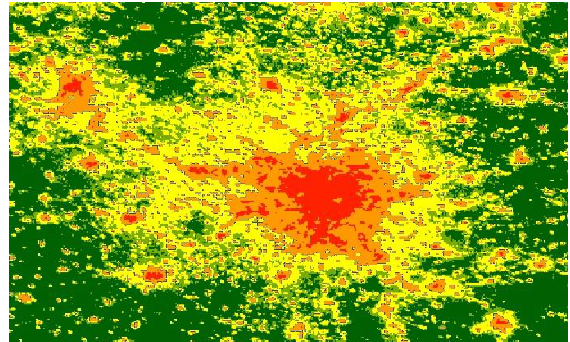
Figure 17. Landscapes Impacted by